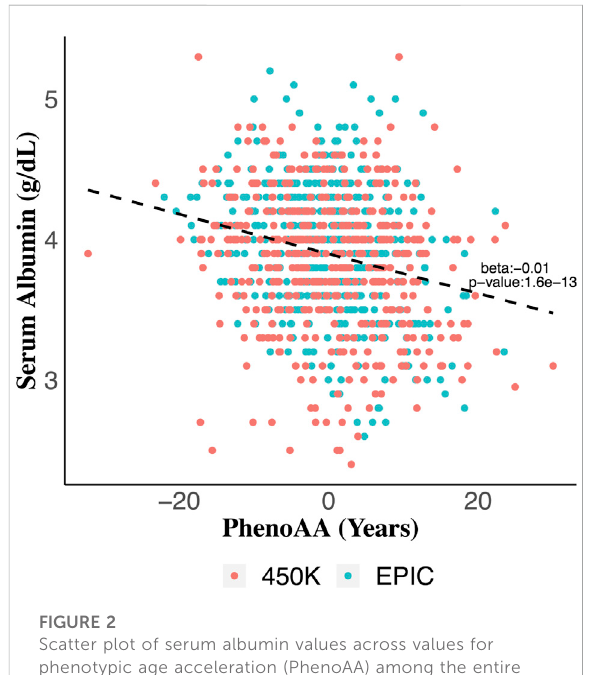
FIGURE 2 Scatter plot of serum albumin values across values for phenotypic age acceleration (PhenoAA) among the entire cohort. Red dots indicate participants from 450K and green dots indicate participants from EPIC. An unadjusted best- fi t line is included (b = -0.01, p -value = 1.6 × 10 – 13